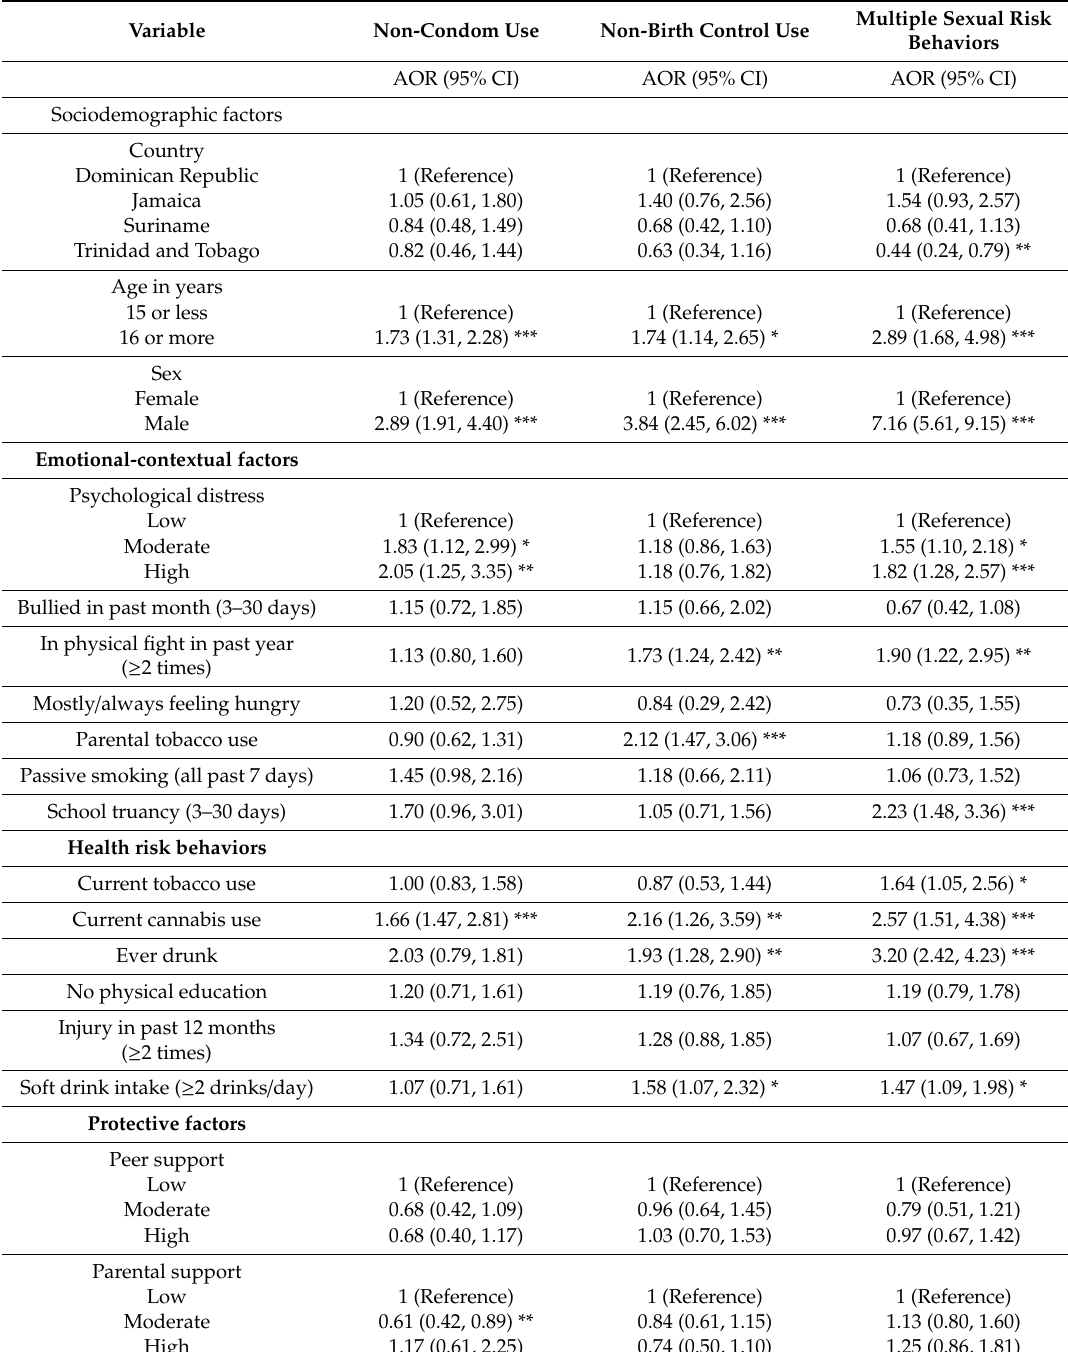
Table 5. Associations with non-condom and non-birth control use and multiple sexual risk